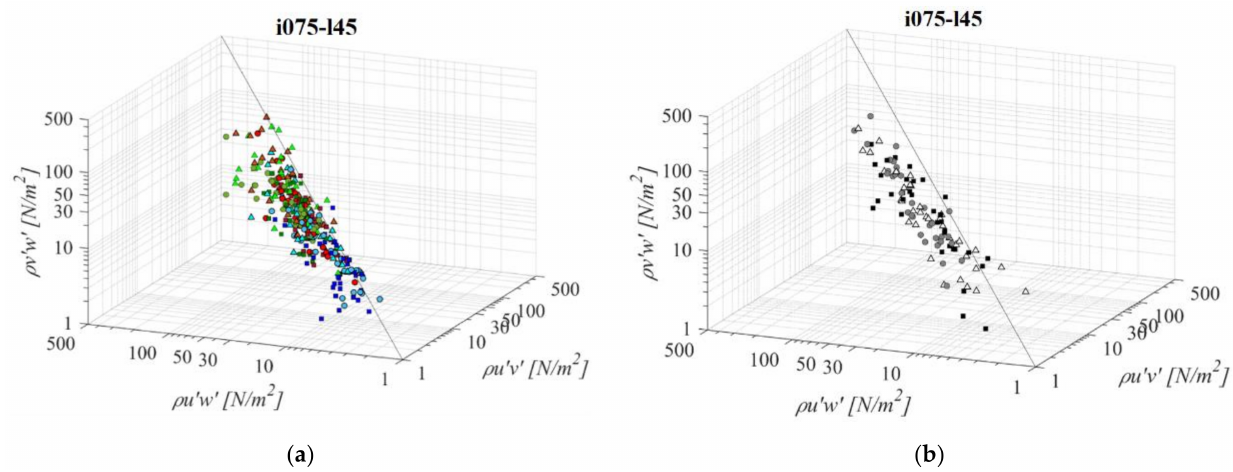
Figure 11. 3D scatterplot of concurrent RSS components for the i075l45 fishway configuration: ( a ) pool-orifice type fishway and ( b ) vertical slot